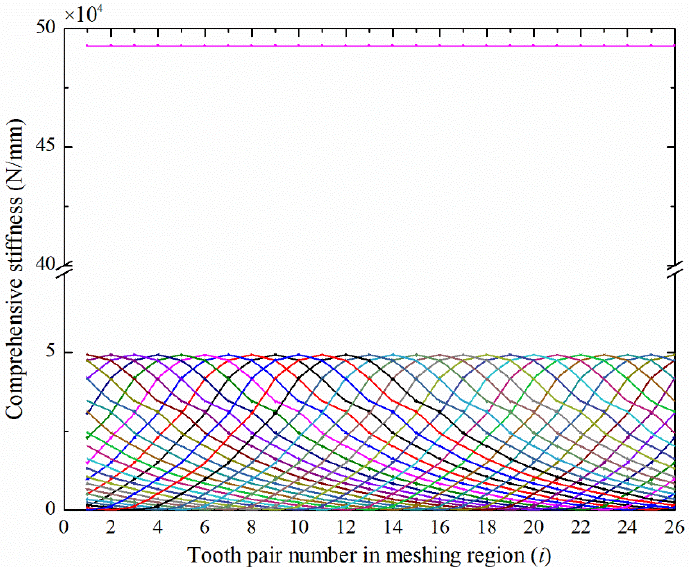
Figure 24. Comprehensive meshing stiffness of the disposable HD.